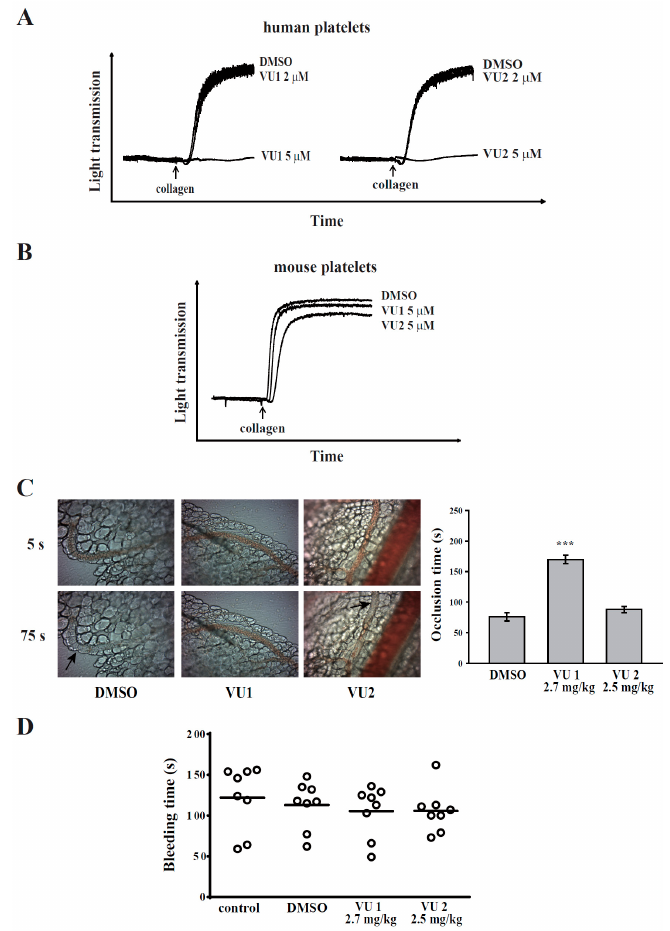
Figure 1. Effects of phospholipase D (PLD)1 and PLD2 on platelet aggregation and thrombus formation. Washed ( A ) human platelets (3.6 × 10 8 cells/mL) and ( B ) mouse platelets (1 × 10 8 cells/mL)